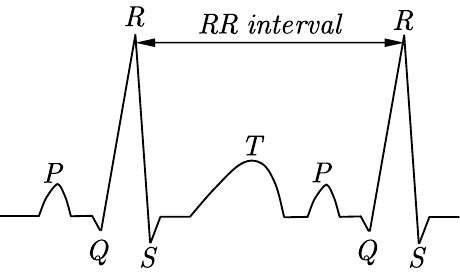
Figure 5. The waveform of sheep photoplethysmogram (PPG).